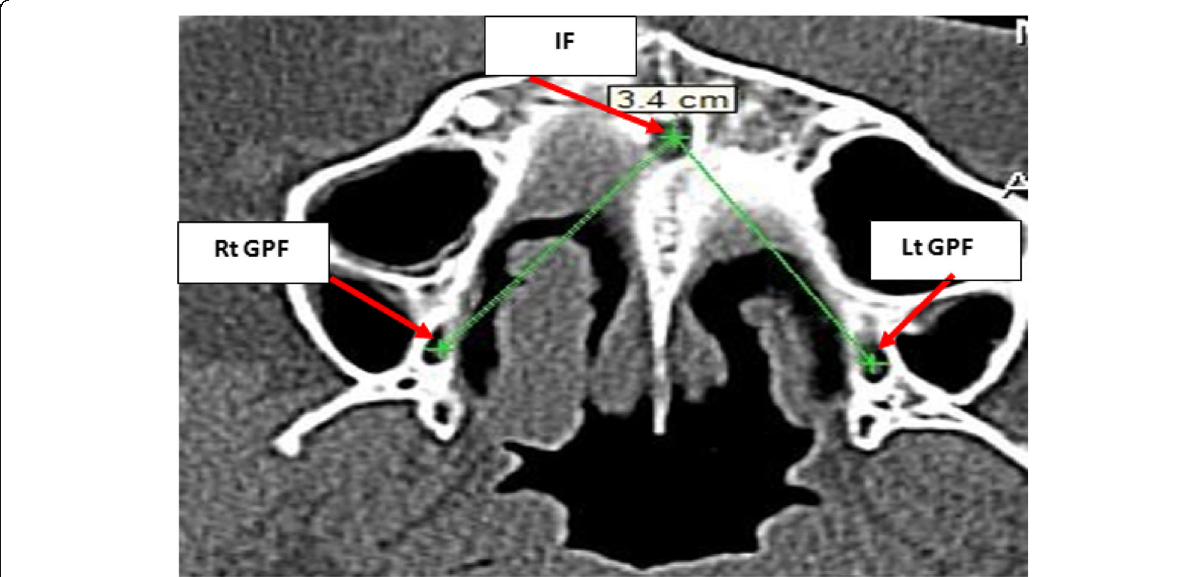
Fig. 12 A CT scan at the region of hard palate illustrating the distance from the center of greater palatine foramen (GPF) to incisive fossa